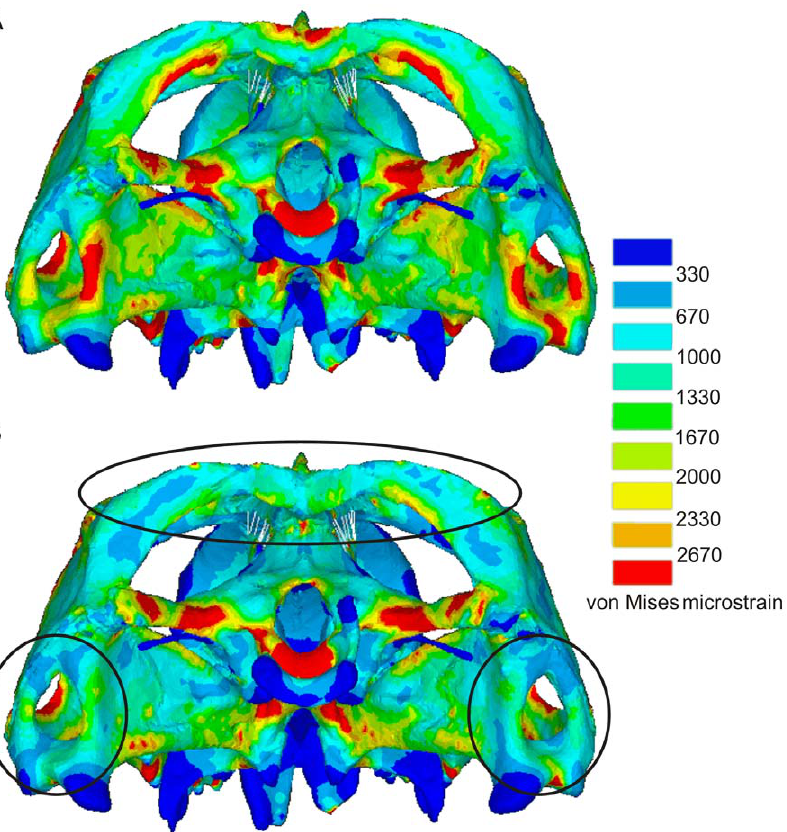
Figure 8. von Mises FEA plots with and without fascia forces. Posterior views of the skull showing von Mises strains predicted by the combined loading model. A. Without including fascial forces and B. including modelled fascial forces (see Figure 2A). Encircled regions highlight areas where strains have changed significantly due to the inclusion of the fascial forces.